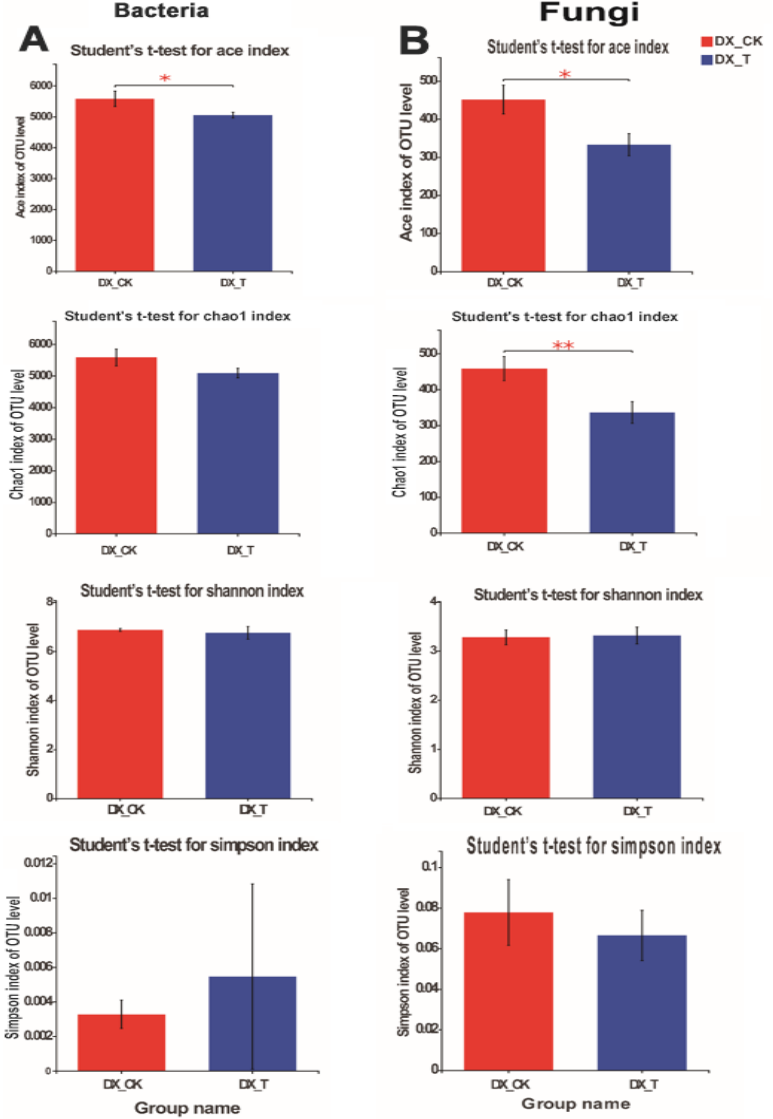
Figure 2. Chao1, ACE, Shannon and Simpson indices showing taxonomic changes in ( A ) bacteria and ( B ) fungi in triple-fumigated soil that had been used to produce watermelon. ‘Triple fumigation’ refers to the simultaneous application of chloropicrin, dimethyl disulfide and metham sodium. The t -test reported the statistical differences (asterisked, * 0.01 < p ≤ 0.05; ** 0.001 < p ≤ 0.01) between the means of three replicates within each graph.